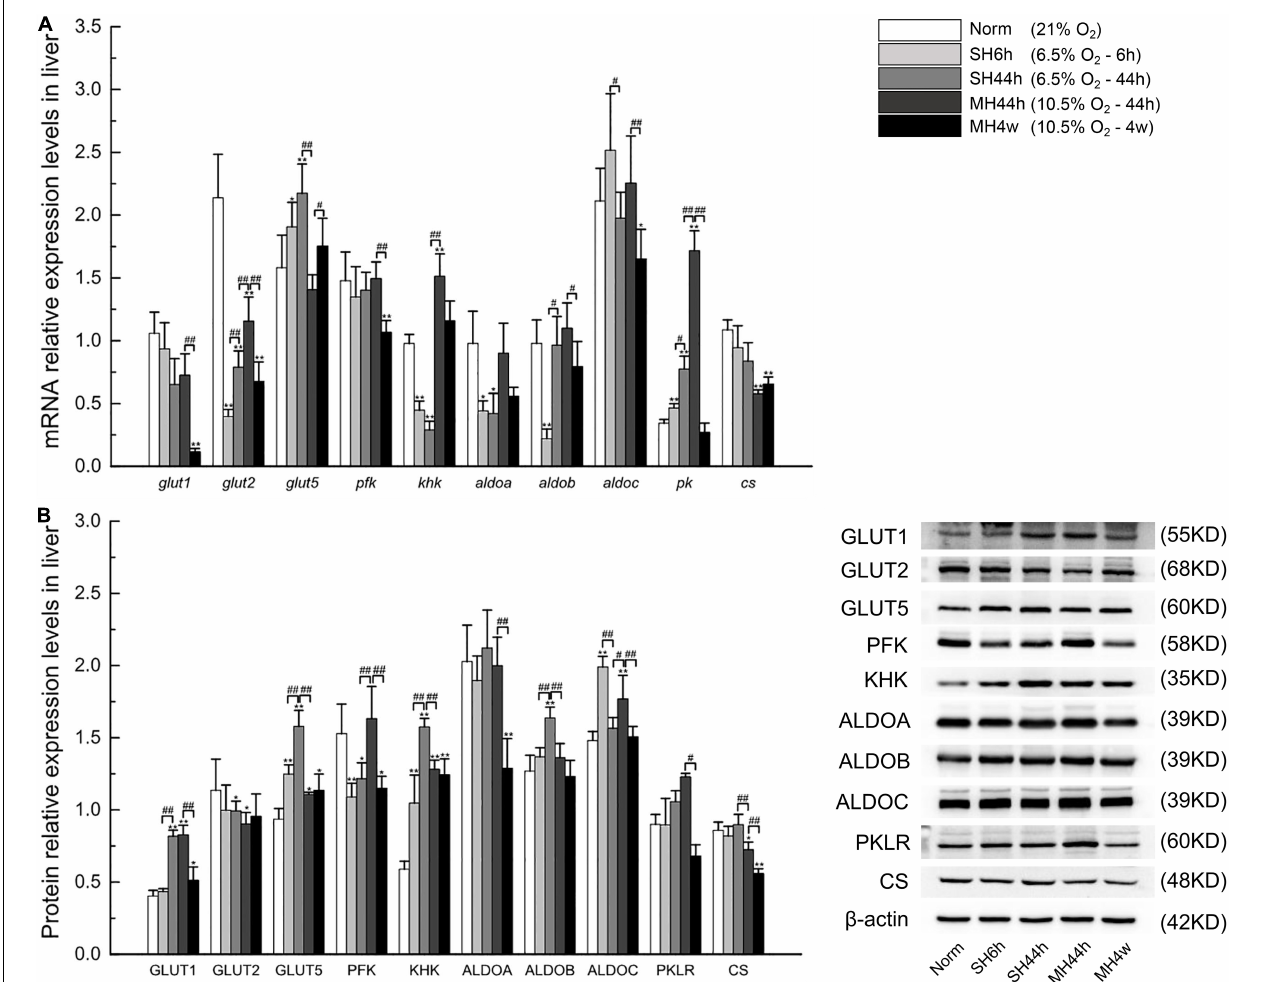
FIGURE 8 | Transcription and translation level analyses of carbohydrate metabolism-related transporters and enzymes in Gansu zokor. (A) Gene expressions graph, (B) protein expression graph, and the representative images of at least three separate blots on the right side of it showing the expression of the proteins. All data are presented as mean ± SD. Statistical symbols: * P < 0.05 and ** P < 0.01 between normoxia and hypoxia treatment; # P < 0.05 and ## P < 0.01 between two hypoxic groups under the same oxygen concentration or the same treatment